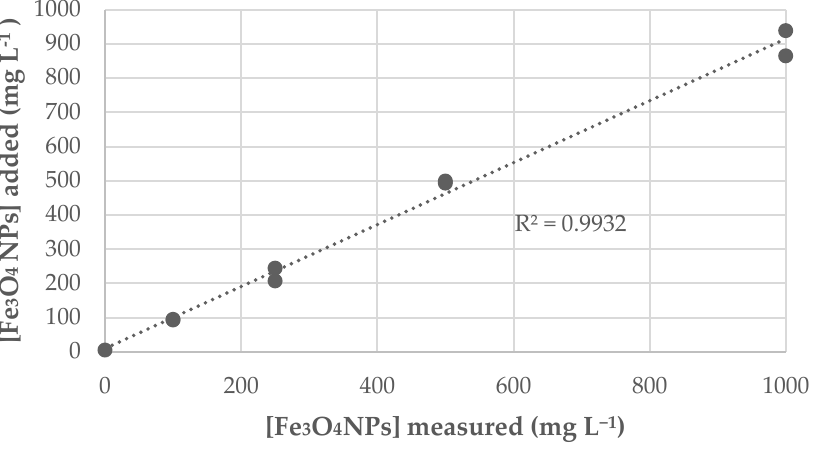
Table 2. Accuracy and precision for iron quantitation in Drosophila melanogaster samples.